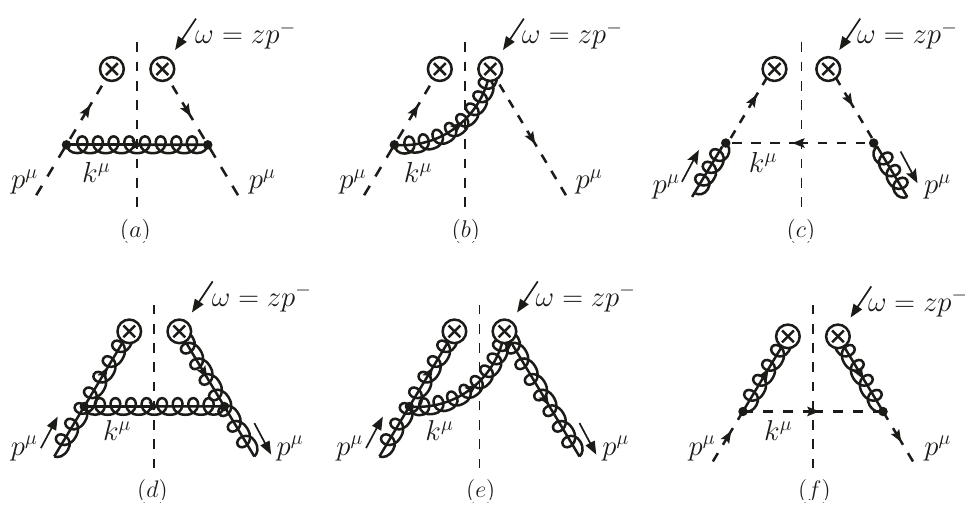
Figure 16 . Nonvanishing diagrams for the computation of the one-loop beam function in pure dimensional regularization and Feynman gauge. Symmetric con(cid:12)gurations are implicit. The mea- surement acts on particles crossing the on-shell cut indicated by the vertical dashed